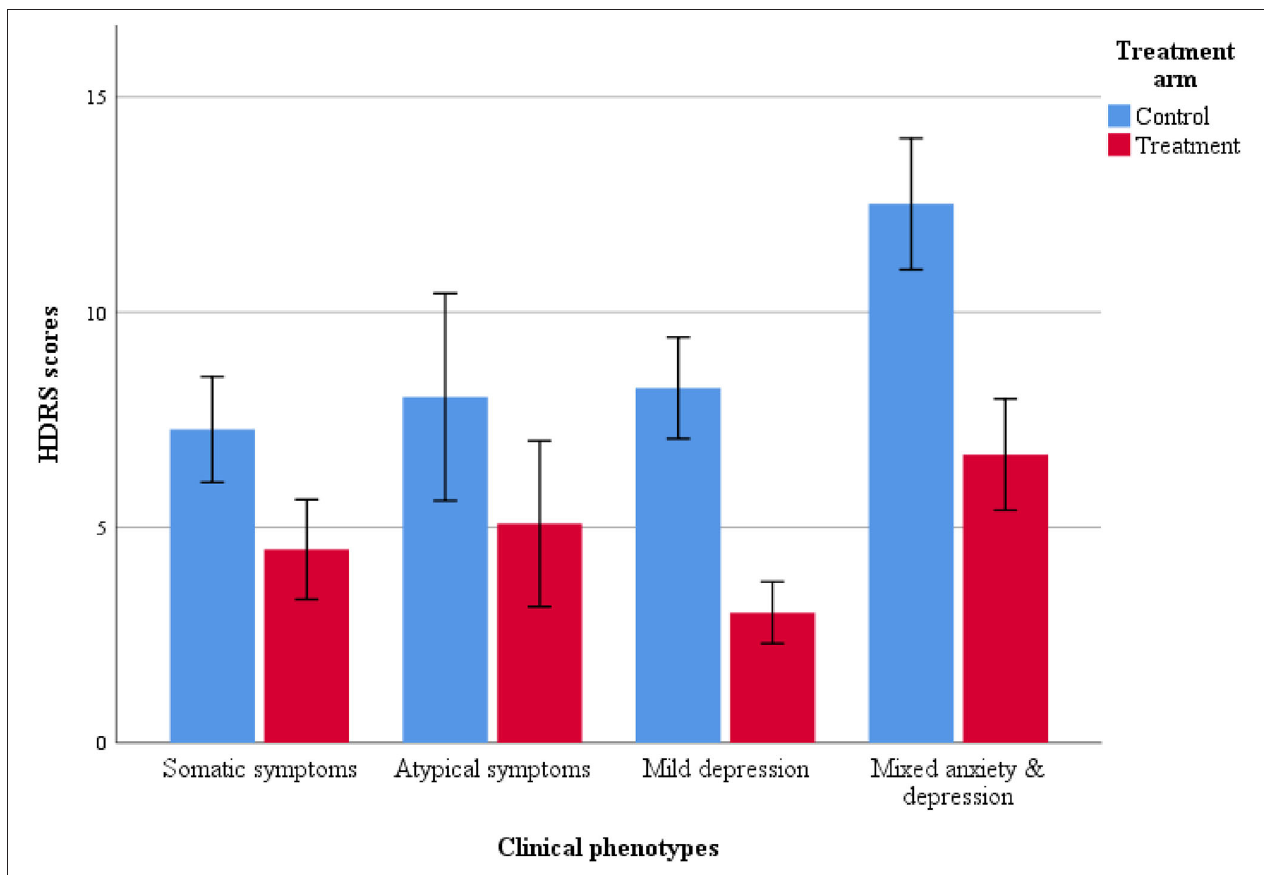
FIGURE 3 | Bar plot for HDRS scores in treatment